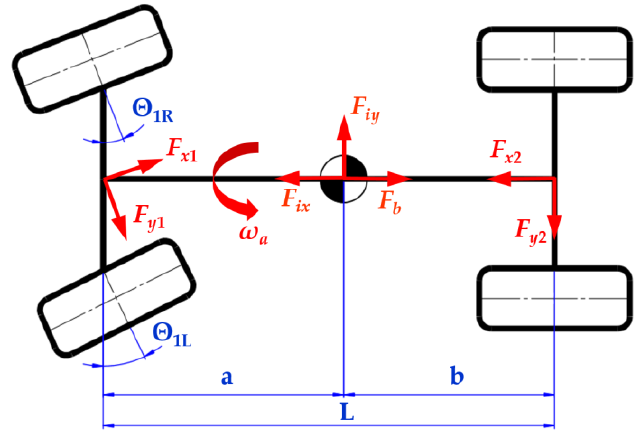
Figure 3. Forces acting at vehicle cornering [48].